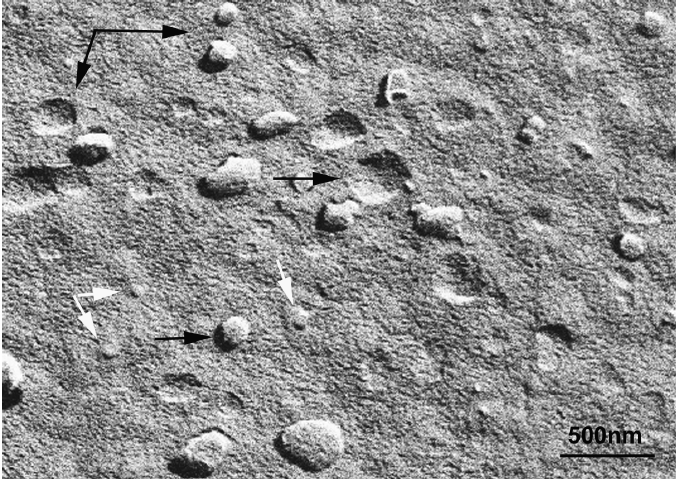
Figure 13. Micrograph of the diluted DPPC/DHPC bicelles (D5) at 37 °C. The black arrows denote vesicle structures of about 200–500 nm and the white arrows point to bicellar